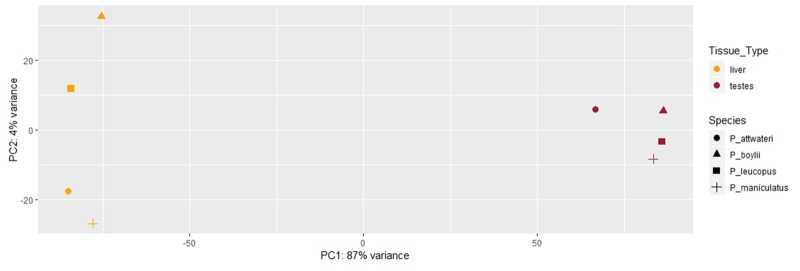
—A PCA plot depicting the similarities and dissimilarities of the liver and testis transcriptomes of four Peromyscus species.